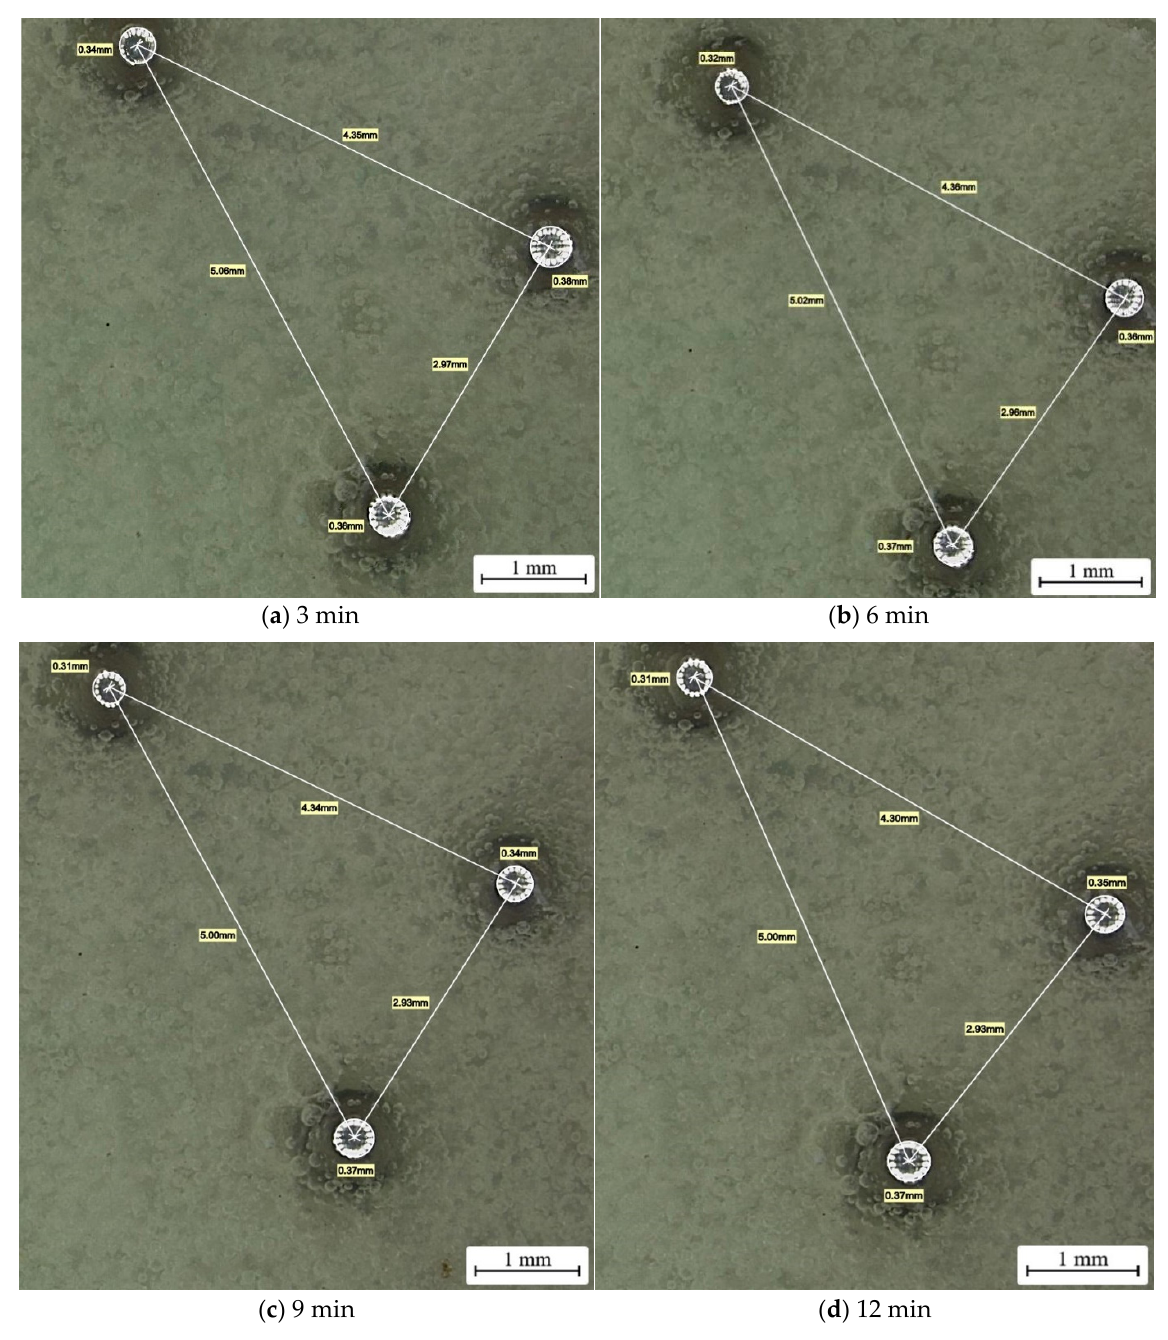
Figure 10. 2D morphology after wear. ( a ) Wear after 3 min (2D). ( b ) Wear after 6 min (2D). ( c ) Wear after 9 min (2D). ( d ) Wear after 12 min (2D).